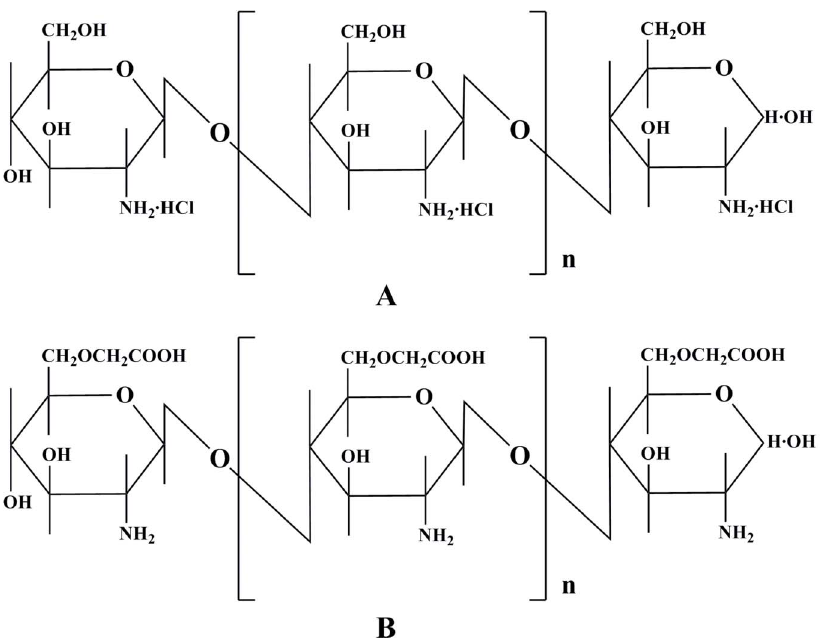
Figure 2. Chemical structure of CMC and COS.